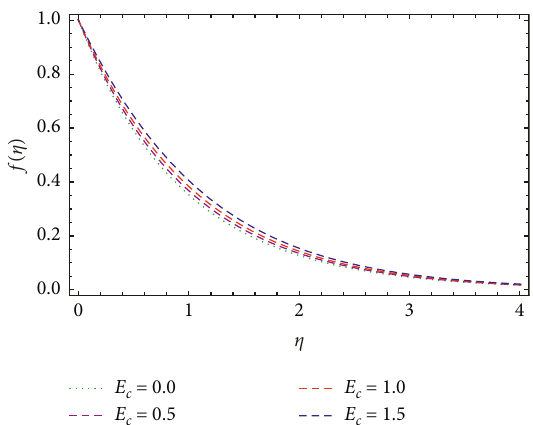
Figure 6: The influence of the velocity profile for different values of E K � 0 . 1 ,f � 0 . 3 , λ � 0 . 2 , Pr � 5 . 0 , β � 0 . 4 , and a ∗ � c , when w b ∗ � 0 . 2 .